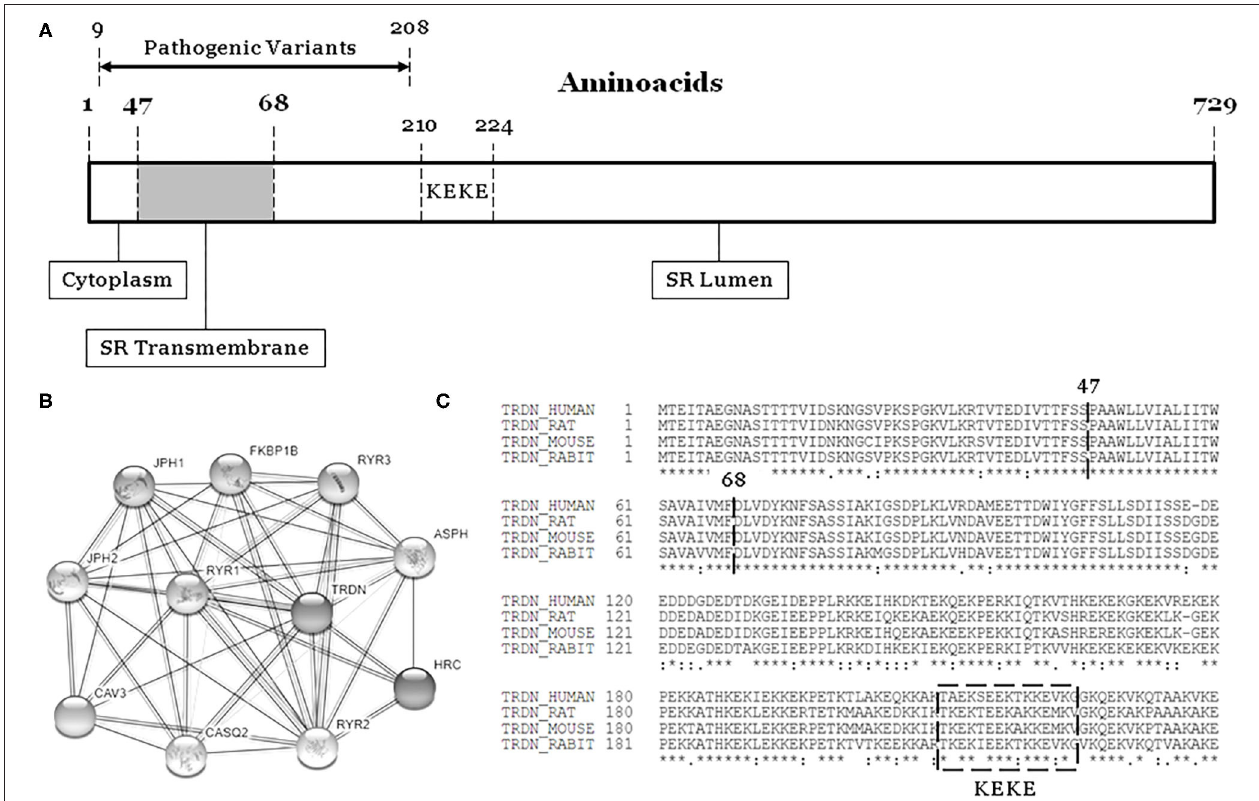
FIGURE 1 | The TRDN structure and closest interaction network. (A) Three domains: Cytoplasm, Transmembrane, and Lumen. (B) Network of 10 closest proteins to Triadin. (C) Conservation between species of main regions containing pathogenic variants (9–208). SR, sarcoplasmatic